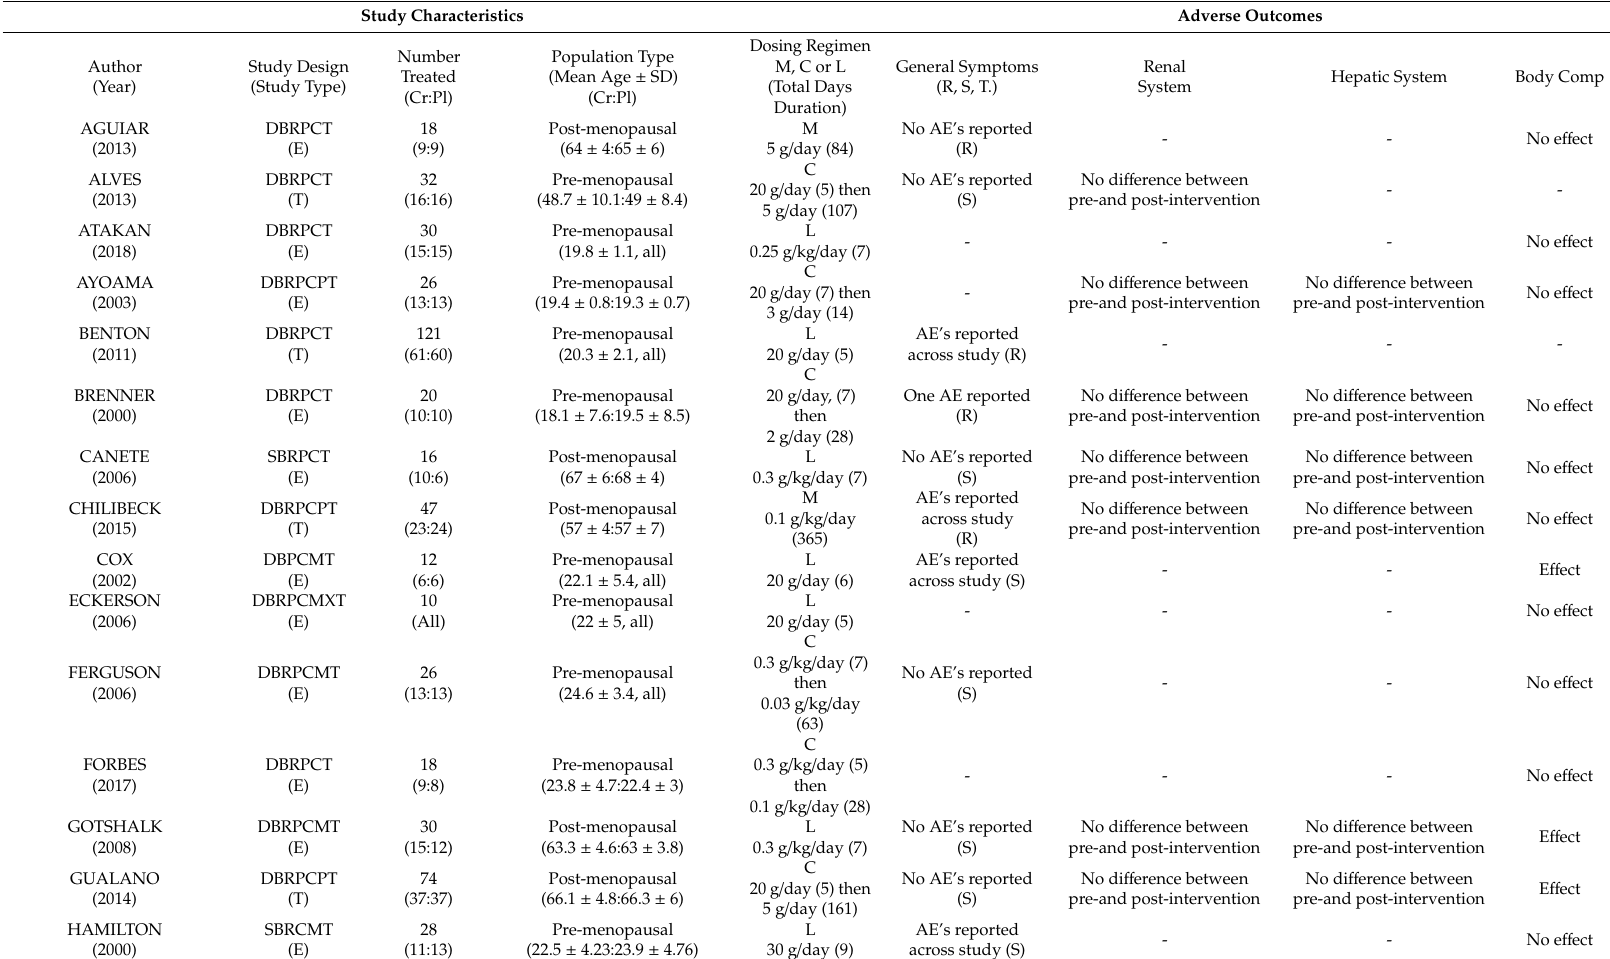
Table 1. Characteristics of studies included in Systematic